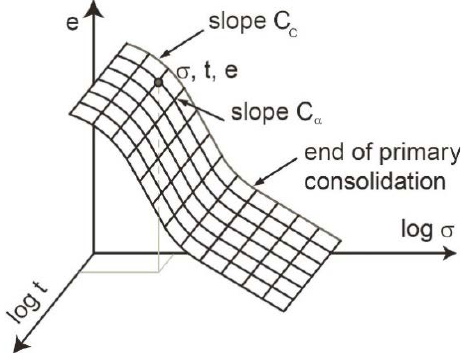
Figure 9: Time- and stress-compressibility interrelationship after Mesri and Godlewski [15].